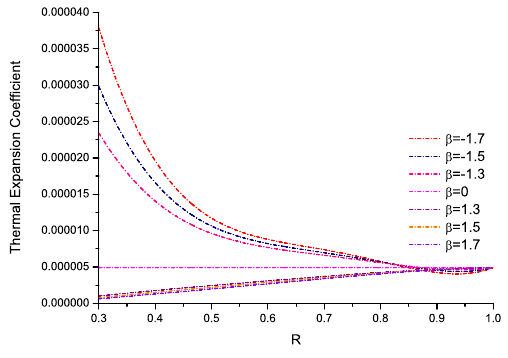
Figure 12: Distribution of modulus of elasticity along radial direction for different values of β